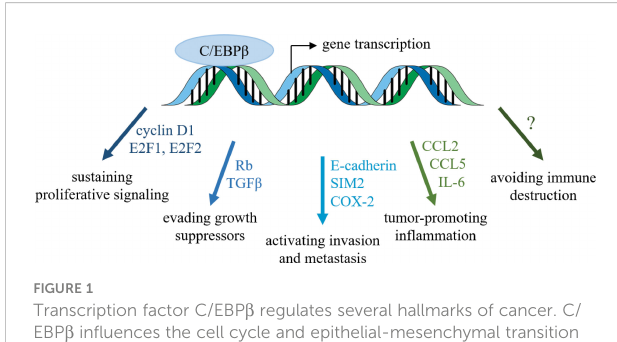
FIGURE 1 Transcription factor C/EBP b regulates several hallmarks of cancer.